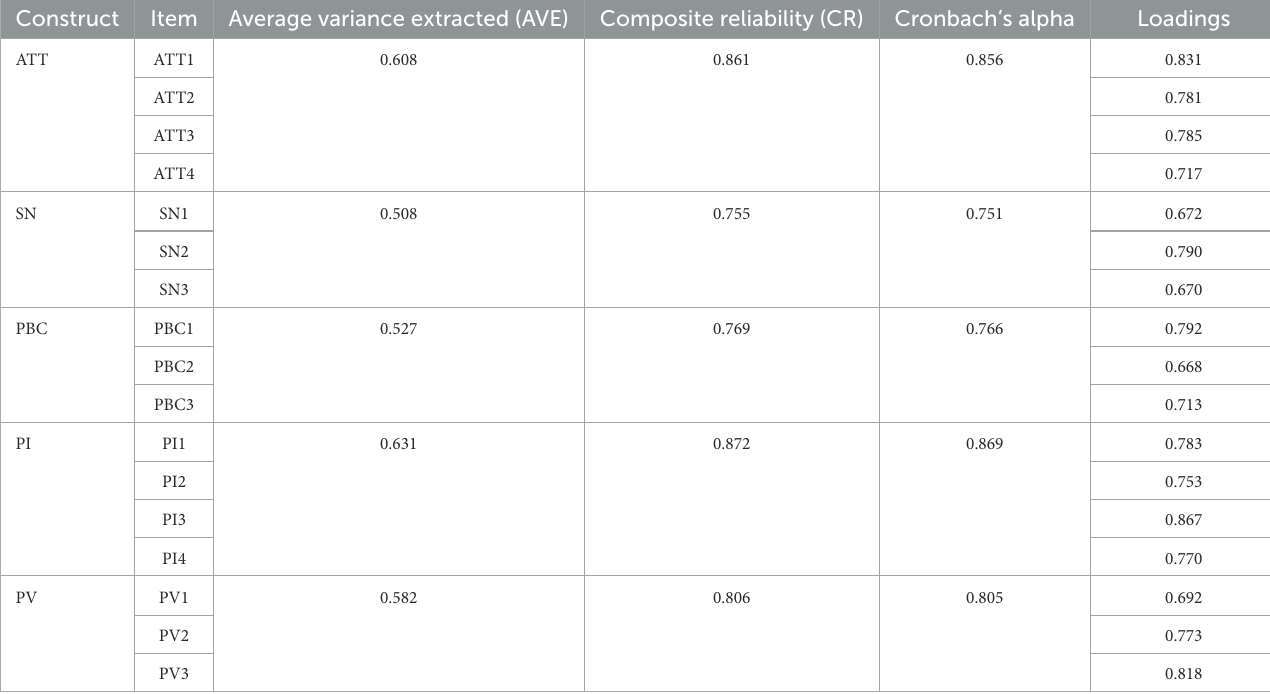
TABLE 3 Reliability and validity analysis.